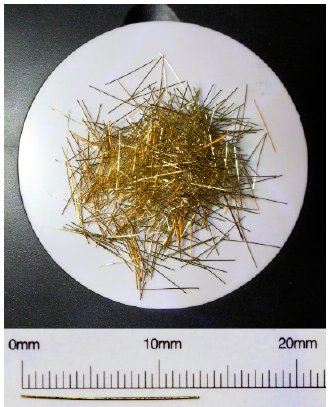
Figure 1. Dramix Ol 13/.16 steel fiber from Bekaert Company.